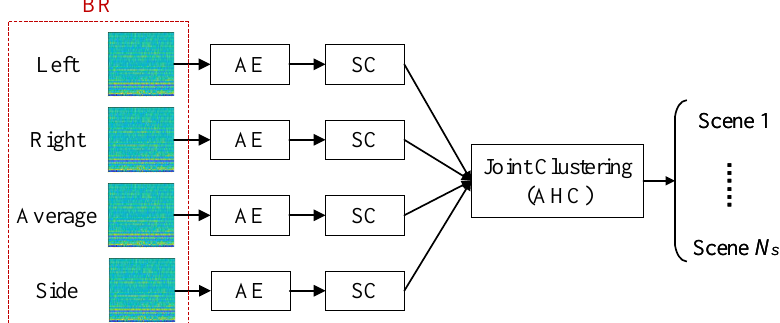
Figure 1. Block diagram of the proposed system, where the term “BR” refers to binaural representation, “AE” refers to an auto-encoder, “SC” refers to spectral clustering, “AHC” is short for agglomerative hierarchical clustering, and N s is the number of acoustic scenes for